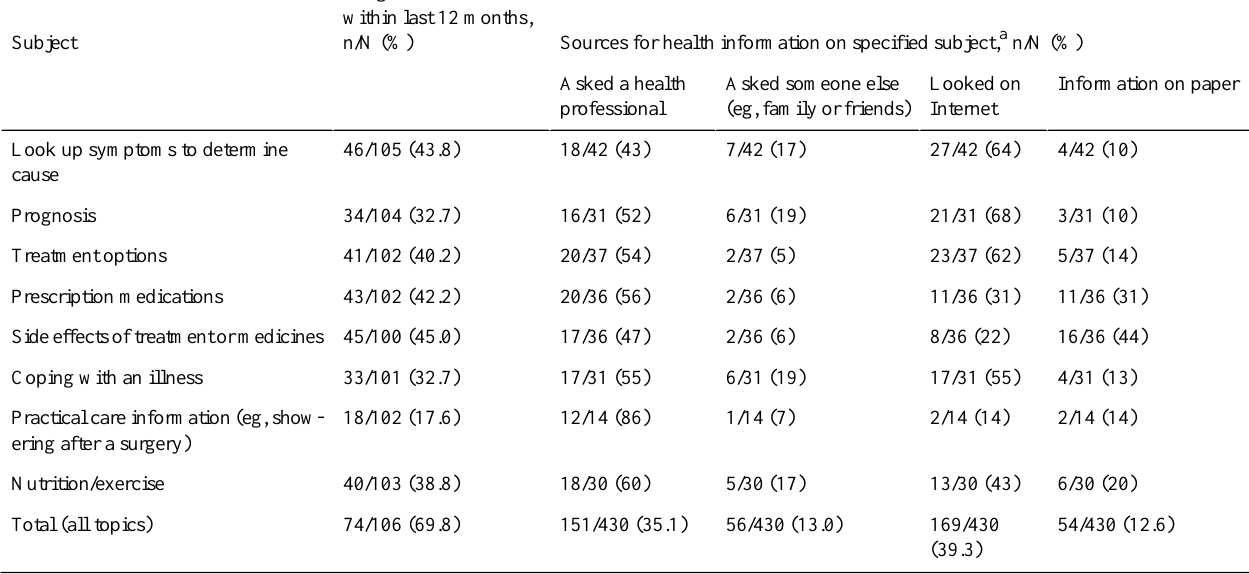
Table 4. Subjects of information seeking.